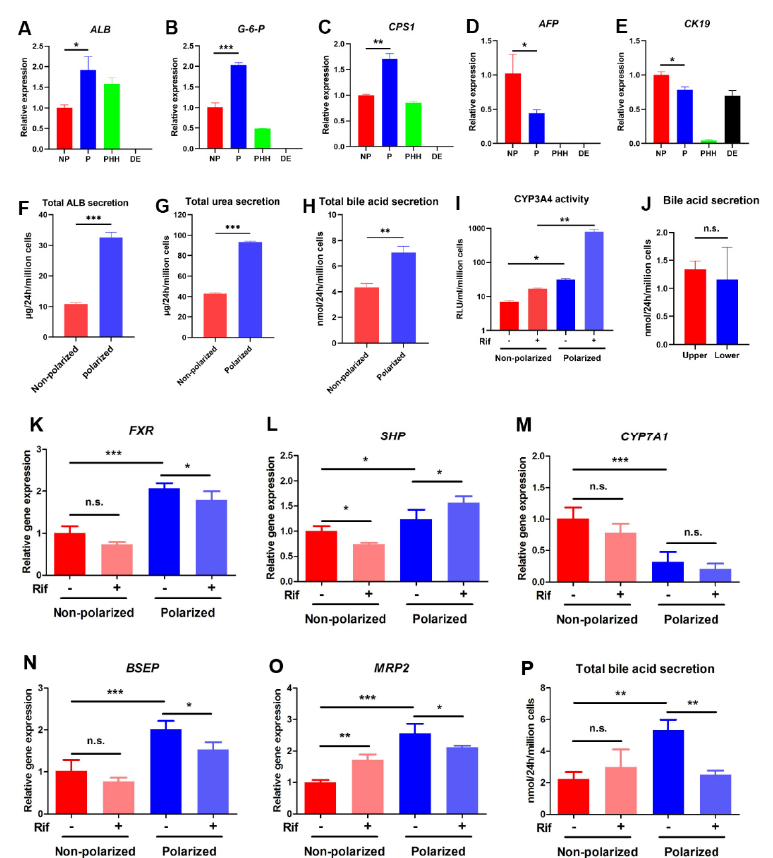
Figure 4. The effects of polarized differentiation on the maturation and function of hEHs. ( A − E ) Quantitative PCR analysis of hepatic maturation-related genes ( ALB , G − 6 − P , CPS1 , AFP and CK19 ) in the non-polarized and the polarized hEHs. Relative gene expressions were normalized to GADPH and calibrated to the non-polarized hEHs. ( F ) ELISA analysis of the total ALB secretion in the non-polarized and polarized hEHs at day 27 after the differentiation. ( G ) Analysis of the total urea secretion by commercial Urea Nitrogen Assay Kit in the non-polarized and polarized hEHs at day 27 after the differentiation. ( H ) Analysis of the total bile acid secretion of the non-polarized and polarized hEHs by using Total Bile Acid Kits. ( I ) Assessment of CYP3A4 activity of the non-polarized and polarized hEHs by commercial P450 − GloTM Assay Kit in the presence of Rif for 2 days using fluorescence-based assays. ( J ) Analysis of the directional secretion of the bile acids in the polarized hEHs by using Total Bile Acid Kits treated with Rif for 2 days. ( K − O ) Quantitative PCR analysis of hepatic bile acid metabolism related genes and apical transporters of the non-polarized and polarized hEHs in the presence or the absence of Rif for 2 days. Relative gene expression represented data normalized to GADPH and calibrated to the non-polarized hEHs without the induction of Rif. ( P ) Analysis of the total bile acid secretion of the non-polarized and polarized hEHs by using Total Bile Acid Kits in the presence or the absence of Rif for 2 days. Data represent the mean ± SD. * p < 0.05, ** p < 0.01, *** p < 0.001; n.s. means no significant.